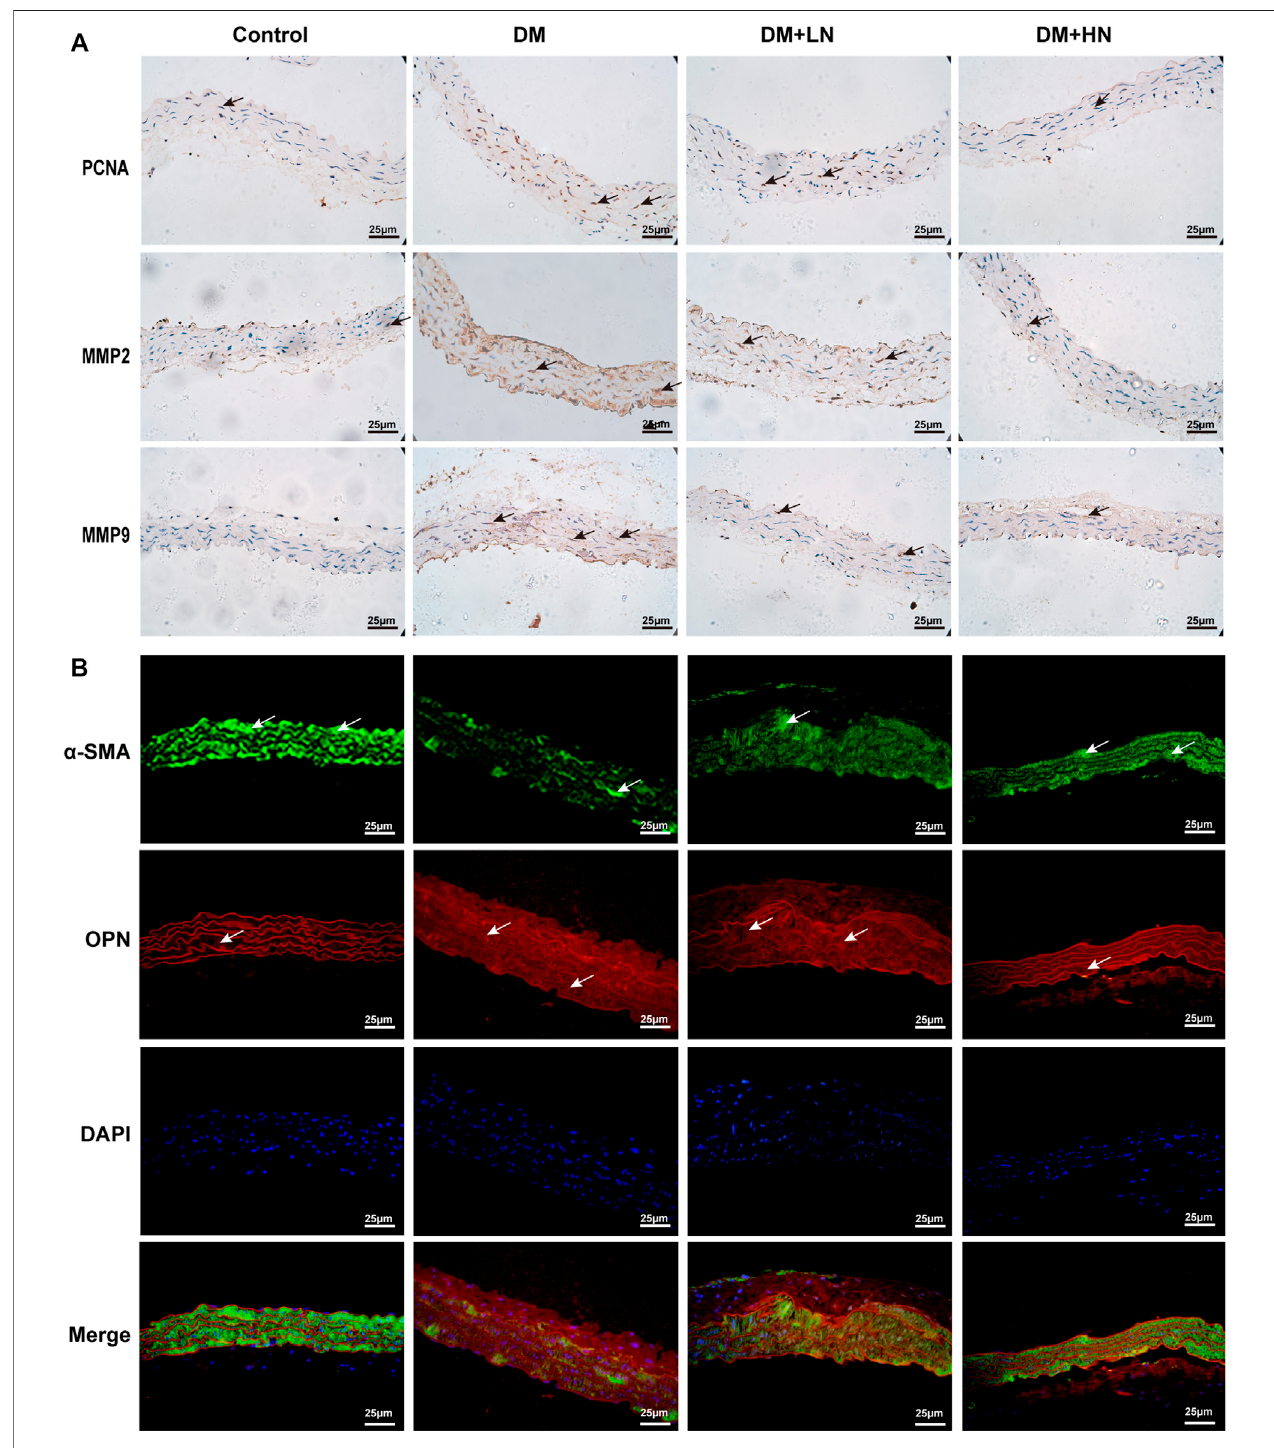
FIGURE 2 | (A) Nar inhibited diabetes induced VSMCs ’ proliferation, migration and phenotype switching in vivo . Immunohistochemical analysis of PCNA, MMP2, and MMP9 expression in the aorta in diverse groups (magni fi cation: 400×). (B) Immuno fl uorescence staining of α -SMA and OPN expression in diverse groups of mice.